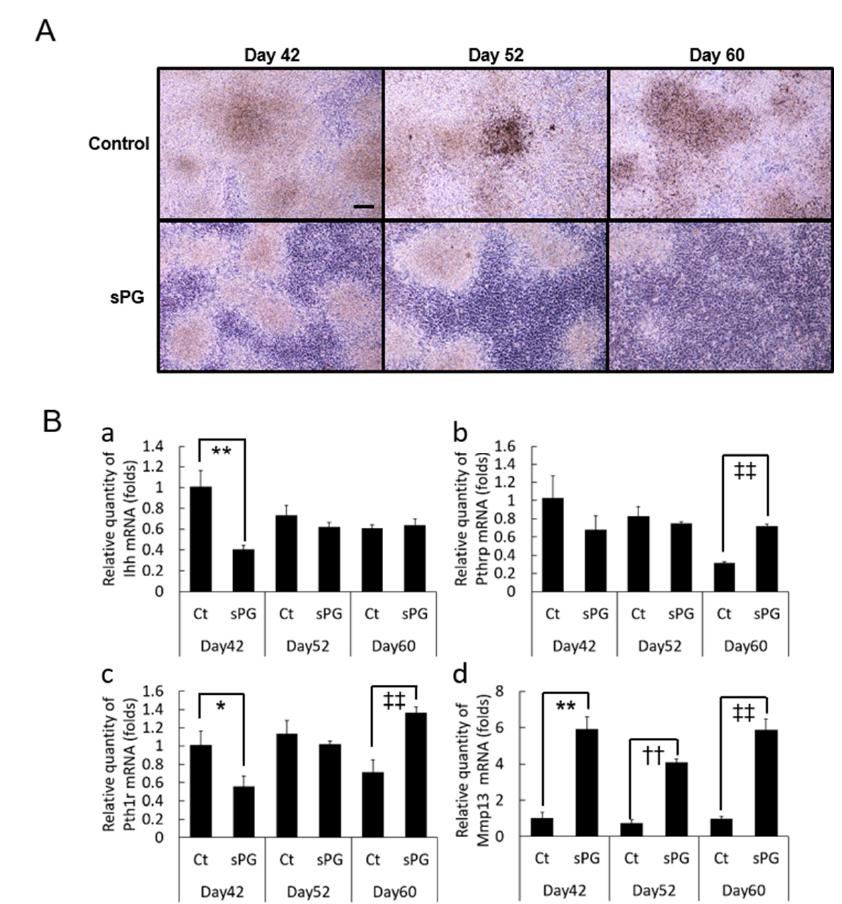
Figure 8. Effect of sPG on loss of calcified layer of ATDC5 cells. ( A ) Cell morphology of ATDC5 cells by phase ‐ contrast micrographs. ATDC5 cells were then incubated in the absence (Ct) or the presence of sPG (50 μ g/mL) under α MEM medium containing 5% FBS and insulin at 37 °C in a humidified atmosphere of 3% CO 2 in air for 14, 24 and 32 days from post ‐ chondrogenic differentiation (28 days). The cell morphology was observed with phase ‐ contrast microscopy. ( B ) Real ‐ time quantitative PCR analysis of mRNA expression on disappearance ‐ related factors of calcified layer, Ihh , Pthrp , Pth1r and Mmp13 . Untreated cells (Ct) or cells treated with sPG (50 μ g/mL) were cultured under α MEM medium containing 5% FBS and insulin at 37 °C in a humidified atmosphere of 3% CO 2 in on days 14, 24 and 32 from post ‐ chondrogenic differentiation (28 days). Relative expression levels of Ihh ( a ), Pthrp ( b ), Pth1r ( c ) and Mmp13 ( d ) in ATDC5 treated without or with sPG were normalized to an endogenous control, RPS18 . These data are presented as the mean ± S.D. of three independent experiments. Significant di ff erences on day 42 show * p < 0.05; ** p < 0.01, on day 52 show †† p < 0.01 and on day 60 show ‡‡ p < 0.01, Student (cid:48) s t-test. Scale Bar = 200 µ